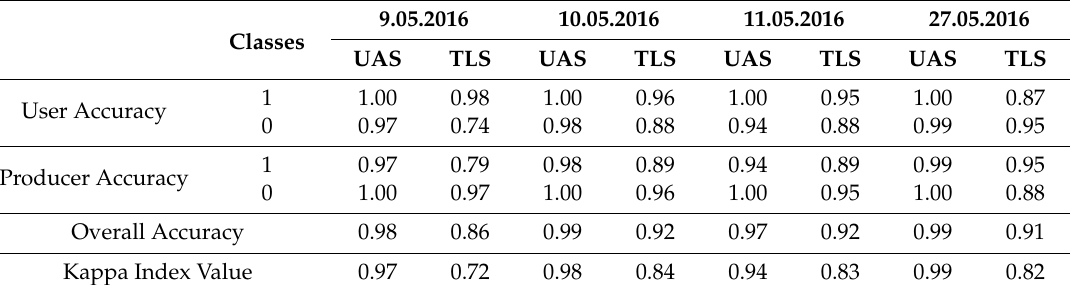
Figure 6. Snow cover maps generated from the UAS and TLS data (Red line: TLS extent; − 1: NoData; 0: Snow-free; 1: Snow-covered). Table 3. Accuracy assessment of classified data of the UAS and TLS (Class 1: Snow-covered and Class 0: Snow-free).